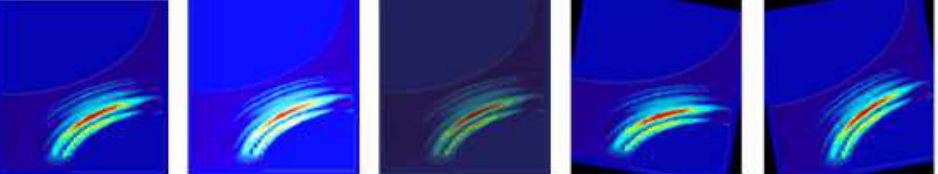
Figure 11. Data augmentations with original mmWave heatmap, increasing the brightness and darkness, rotating left 10 degrees, and rotating right 10